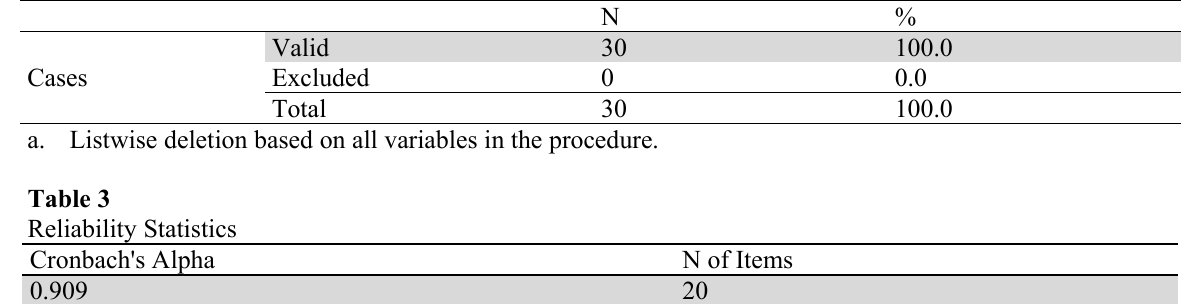
Case Processing